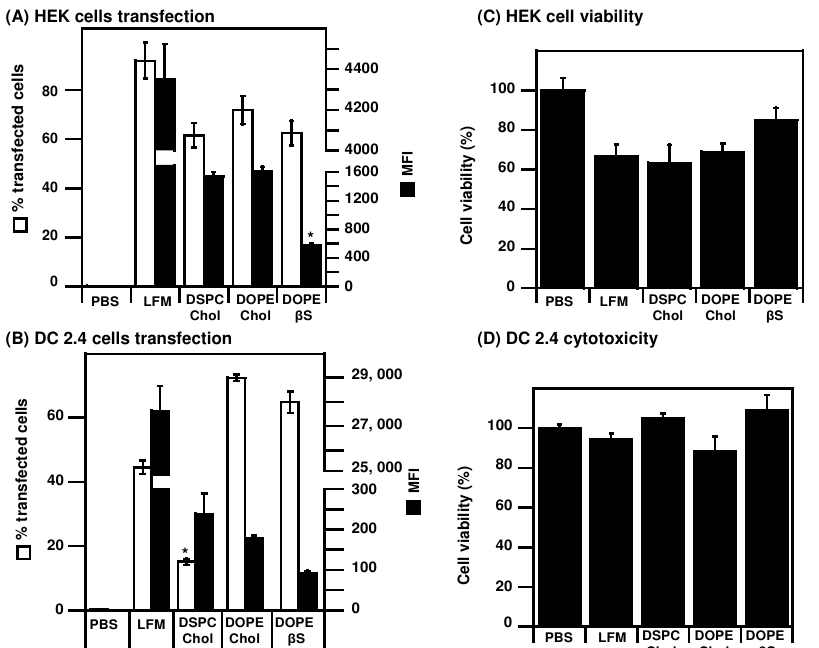
Figure 2. Evaluation of mRNA LNPs transfection efficiency: LNPs prepared with EGFP mRNA were used to transfect HEK cells ( A , C ) or DC 2.4 cells ( B , D ). Transfection efficiency and cytotoxicity were measured 24 h after transfection. Data are presented as mean ± SD of two experiments performed in triplicates, * p < 0.05 compared to other LNPs. As most in cellulo studies on mRNA LNPs use human cancer cell lines or immortal- ized cells [20,35,48], we also transfected human HEK cells (Figure 2A,C). In these immor- talized cells, the three types of LNPs were capable of transfecting more than 60% of cells, albeit lower than the commercial LFM standard (90% transfected cells). Contrary to DCs, lower MFI were detected in HEK cells transfected with DOPE/βS LNPs (583 MFI) com- pared to DSPC/Chol LNPs (1539 MFI) and DOPE/Chol LNPs (1607). In HEK cells, their transfection with LFM, DOPE/Chol LNPs, and DSPC/Chol LNPs induced cytotoxicity leading to only 65–70% viable cells after transfection (Figure 2C). Interestingly, DOPE/βS LNPs were better tolerated with 80% viable cells after transfection. As our focus is mRNA vaccination, we also evaluated the transfection efficiency of those formulations on the murine DC2.4 DC cell line, [49–51] (Figure 2B,D). The percent- age of transfected DC is lower (40–70%) compared to that of HEK cells (60–80%). Lower